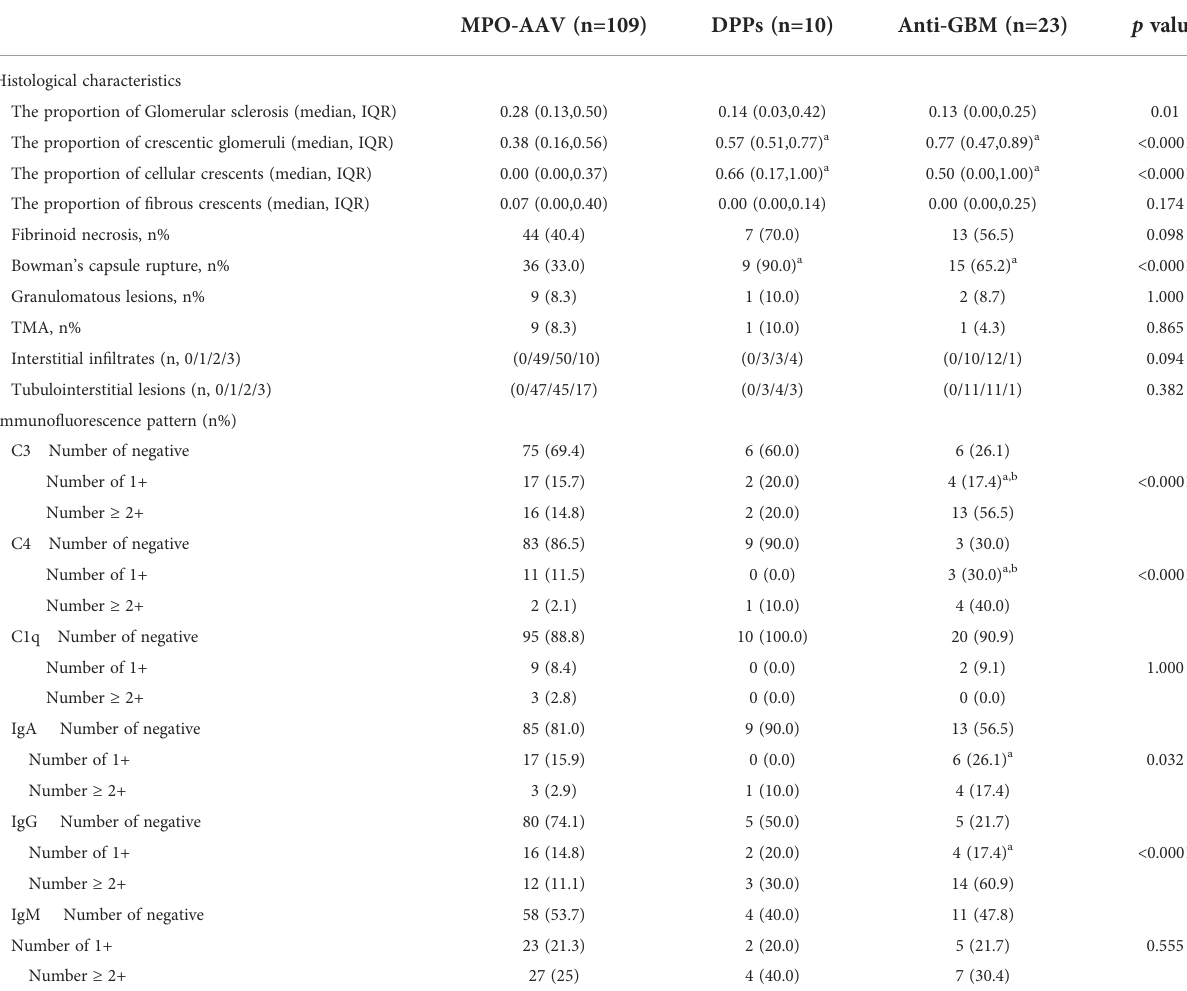
TABLE 2 Pathological